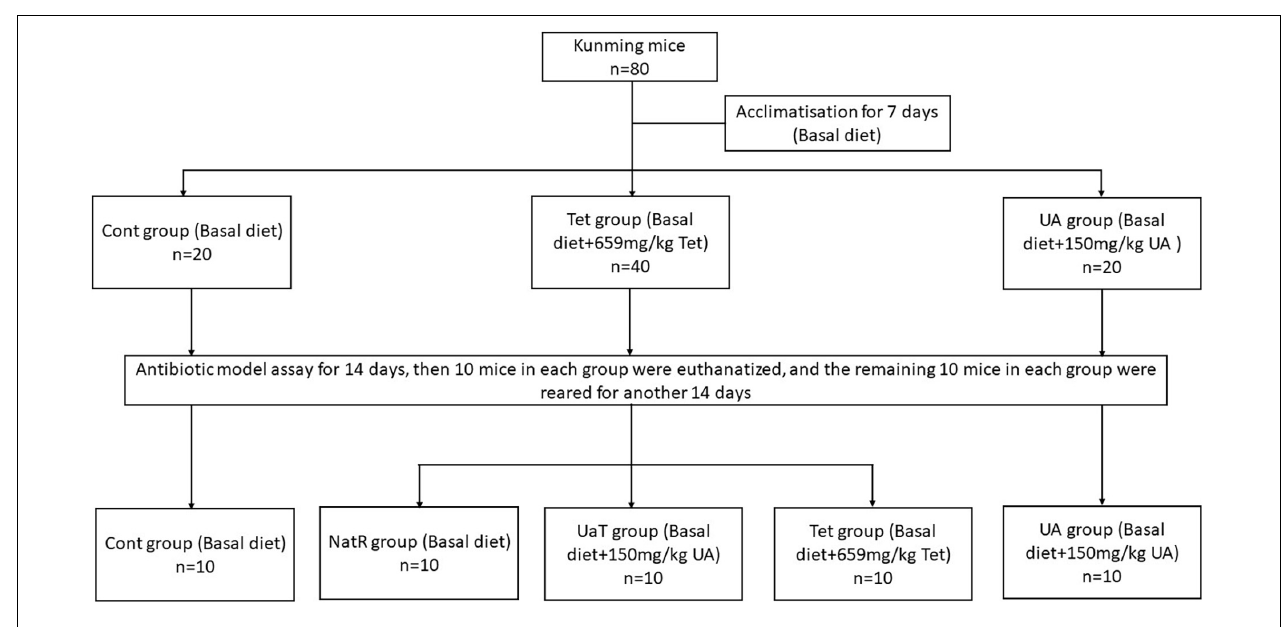
FIGURE 1 | Animal experimental design. Control group (Cont), Chlortetracycline group (Tet), Ursolic acid group (UA), Natural group (NatR), Ursolic acid Therapy group (UaT). The effective concentration of ursolic acid and chlortetracycline was ≥